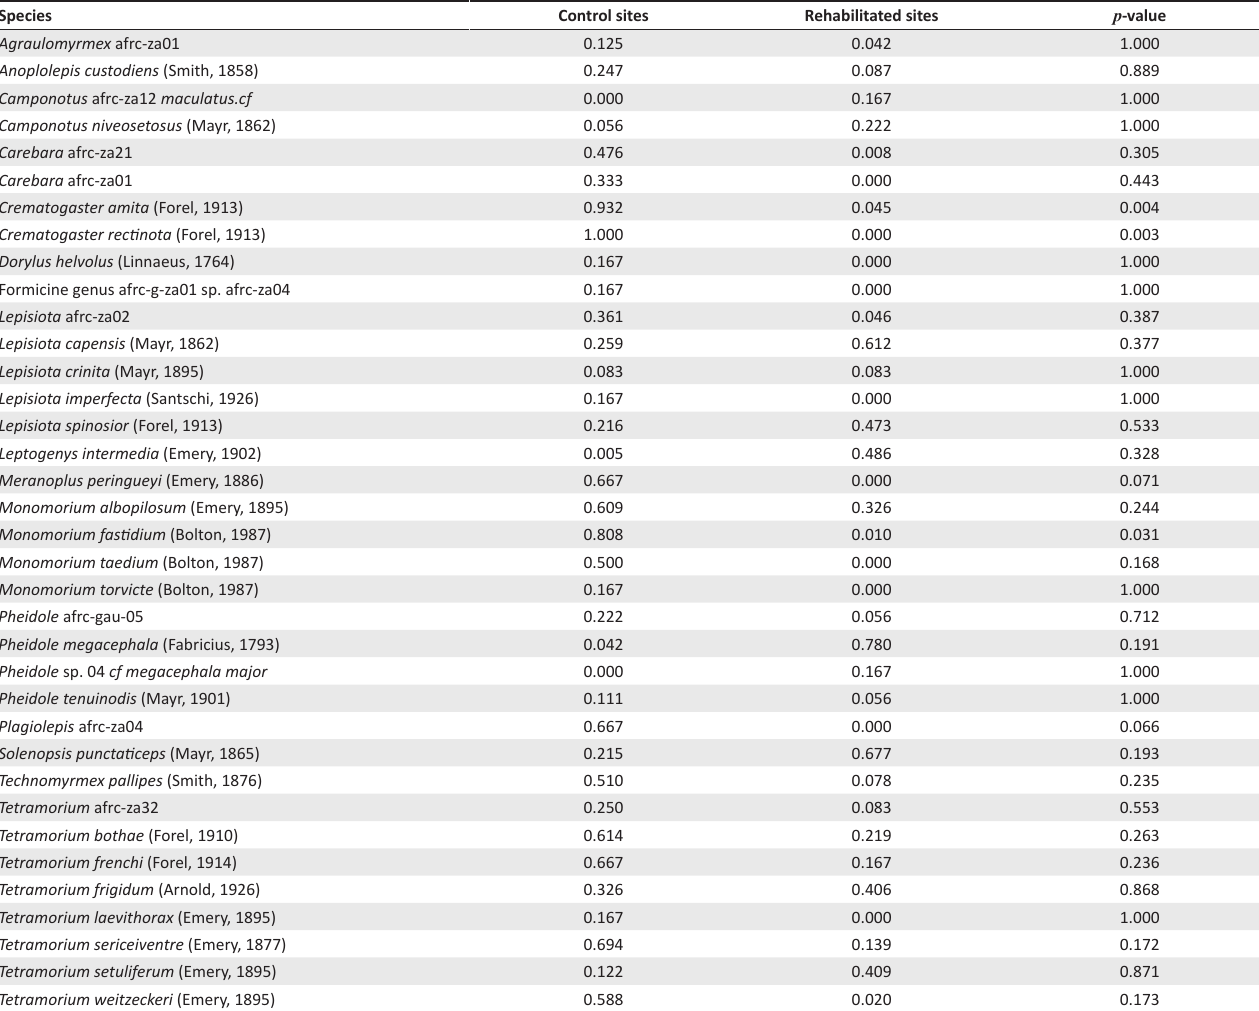
TABLE 1-A5: Indicator values generated in Rstudio. Species fulfilling the criteria (IndVal > 70 % , p < 0.05) are identified as indicator species.